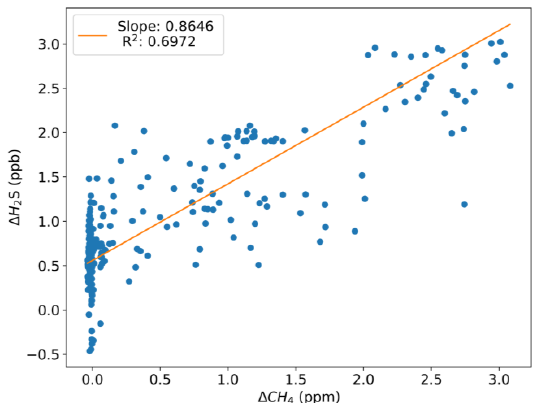
Figure 8. One-minute ΔH 2 S to ΔCH 4 MRs from Seneca on 17 November 2021. The slope of 0.8646 and R 2 value of 0.6972 ( n = 292) together show that the ratio between the two pollutants was significant at Seneca.